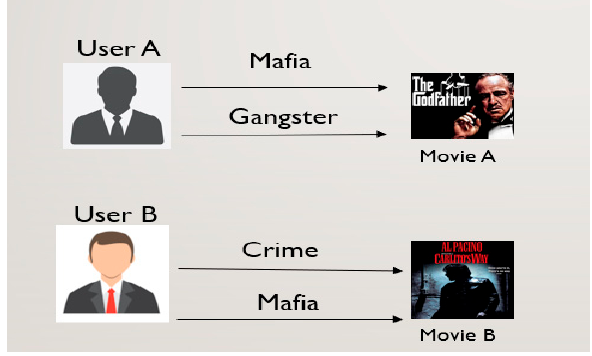
Figure 9. Tag annotation.